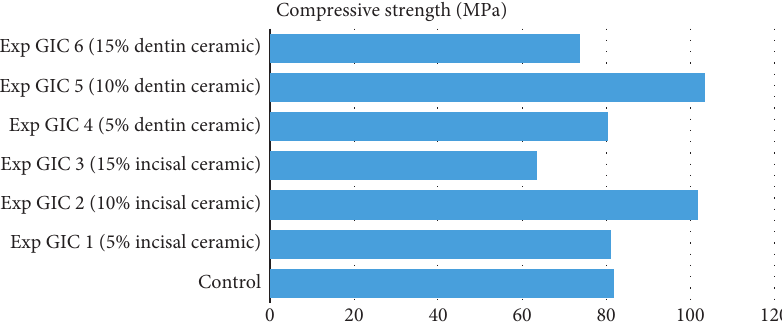
Figure 1: Compressive strength of samples in Group 1.